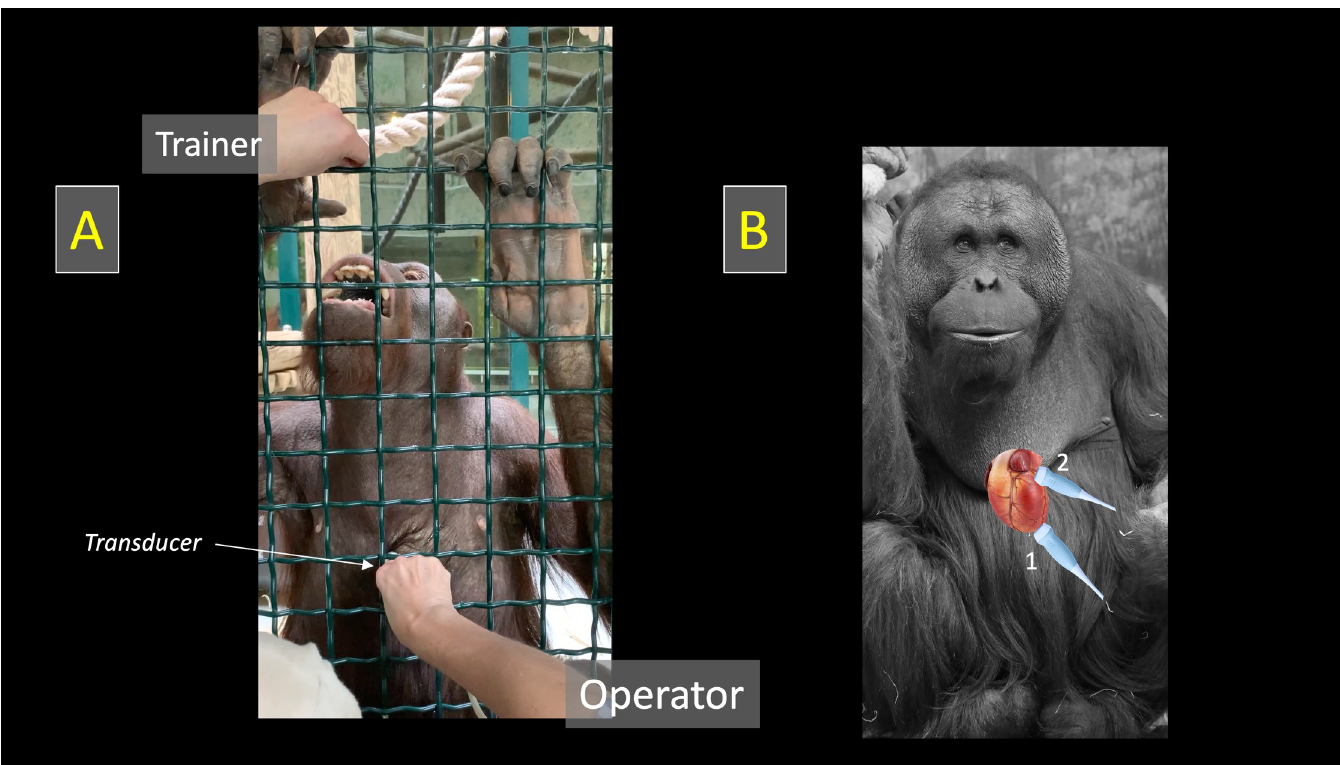
Fig 1. Orangutan positioning for echocardiographic examination and probe placement. Orangutan positioning for echocardiographic examination (A) and probe placement (B) for obtaining the apical long-axis views (1) and the parasternal short-axis view at the level of the aortic valve (2). Fig 1B : courtesy of Emmanuel Baril (Ménagerie , le zoo du jardin de plantes , Paris)